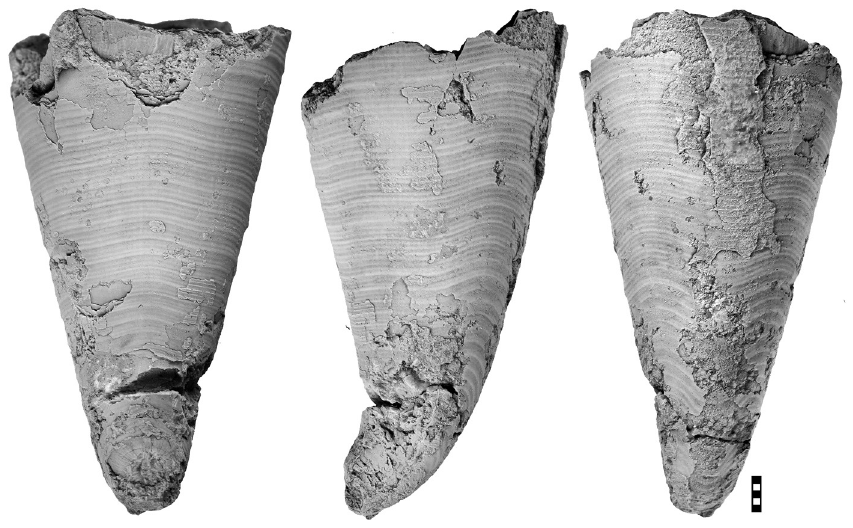
Fig. 17. Ancistroceras undulatum (Boll, 1857) from the Upper Grey Orthoceratite Limestone; specimen MB.C.11697a (Hoyers 1912 Coll.) from Skowarcz (former Schönwarling); previously figured by Foerste (1930: pl. 41 fig. 1); dorsal, lateral and ventral views. Note imprints of the vascular system near the apex visible in the photograph on the left. Scale bar units = 1